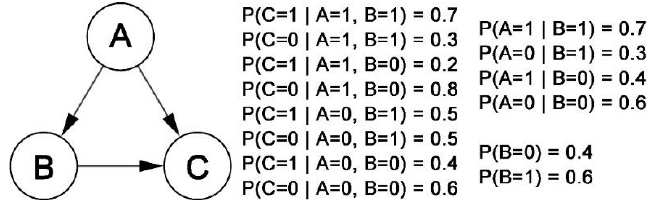
Figure 2. Example of a discrete Bayesian